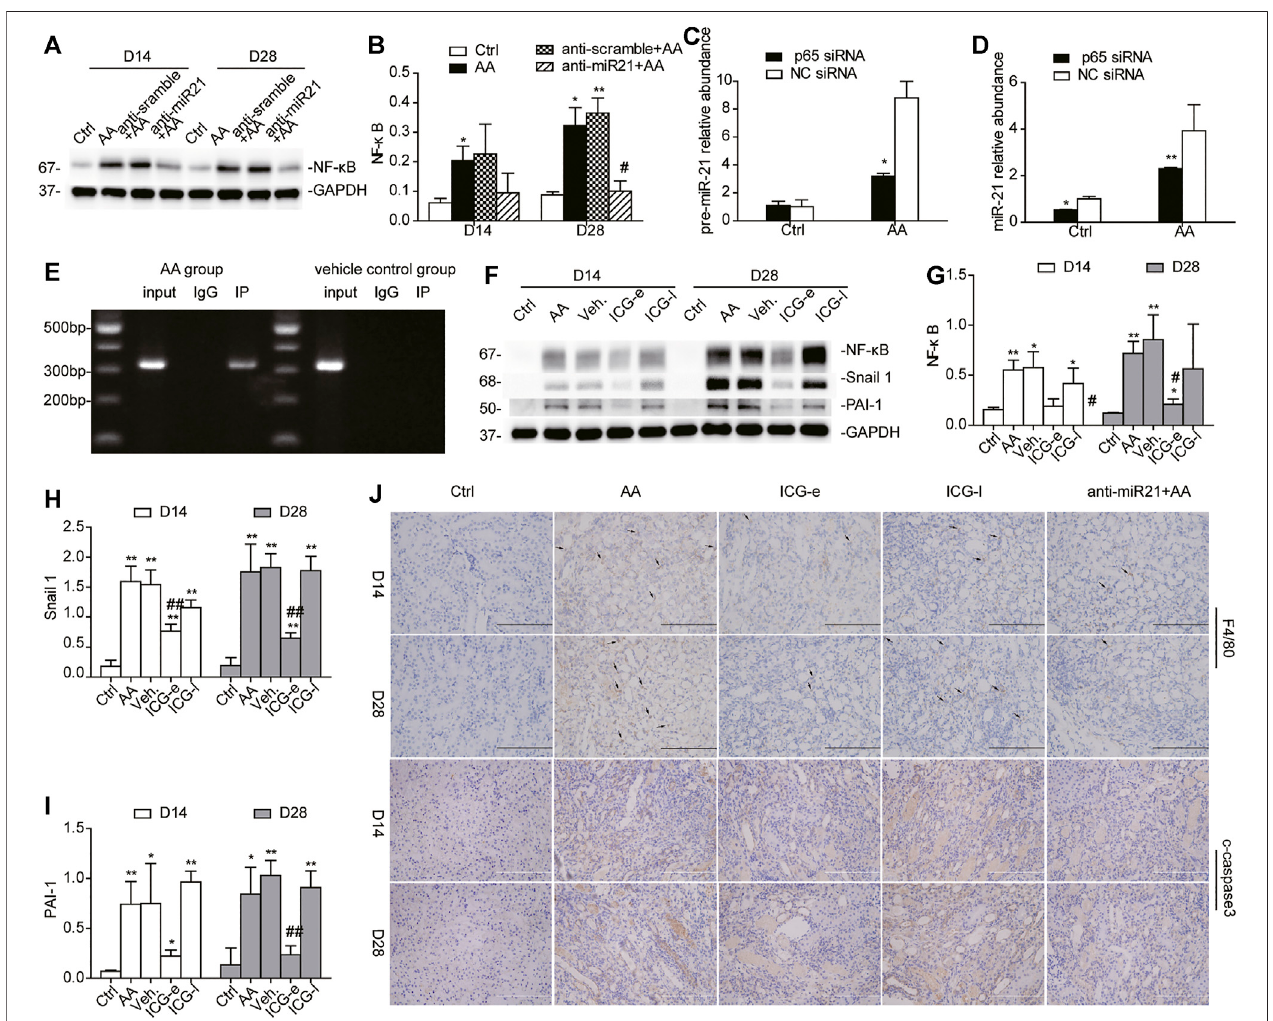
FIGURE 8 | Inhibition of miR-21/Wnt signaling moderates renal in fl ammation and apoptosis. (A, B) Western blots and quantitative data of NF- κ B protein in the kidneys. * p < 0.05and ** p < 0.01 vs. controls. # p < 0.05 and ## p < 0.01 vs. anti-scramble controls. (C,D) Levels ofpre-miR-21 and miR-21 in HK2cells treated withNF- κ B p65 siRNA 12 h before AA exposure. * p < 0.05 and ** p < 0.01 vs. siRNA controls. (E) ChIP assay of NF- κ B and miR-21 in mTECs in AA-treated and vehicle control groups. (F – I) WesternblotsandquantitativedataofNF- κ Bp65, PAI-1,andsnail1inthekidneys.* p < 0.05and** p < 0.01vs.controls, # p < 0.05and ## p < 0.01vs. vehicle controls (Veh), n (cid:2) 3. (J) Immunohistochemistry staining of c-caspase three and F4/80 in the kidneys (magni fi cation, 200 × , bar (cid:2) 200 μ m). The black arrow indicates